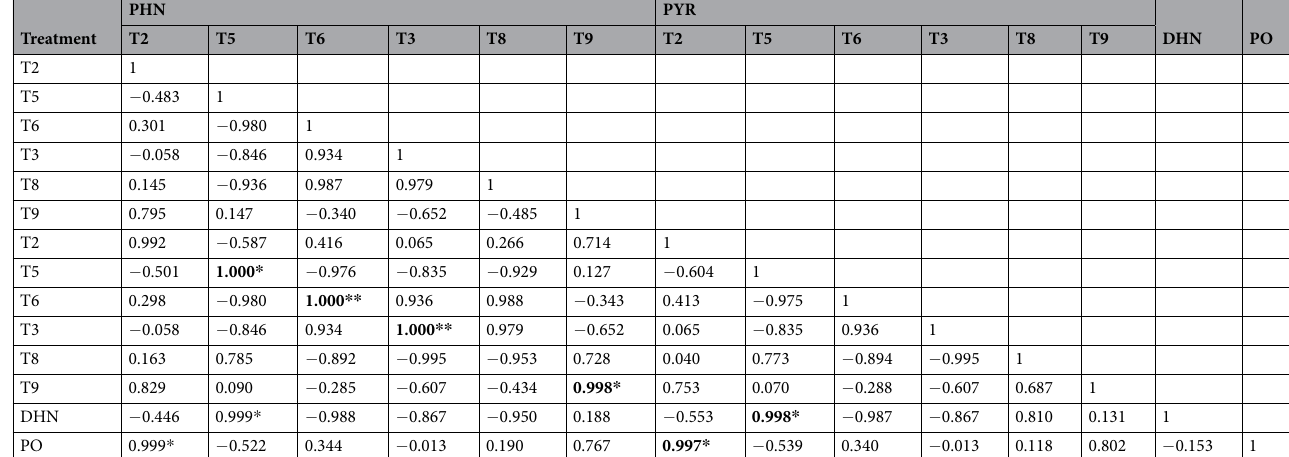
Table 2. Correlations between residual concentrations of PAHs and different biological parameters in planted soil (n = 18). PHN: Phenanthrene. PYR: Pyrene. DHN: Dehydrogenase. PO: Polyphenol oxidase. * Correlation is significant at p < 0.05. ** Correlation is significant at p < 0.01.